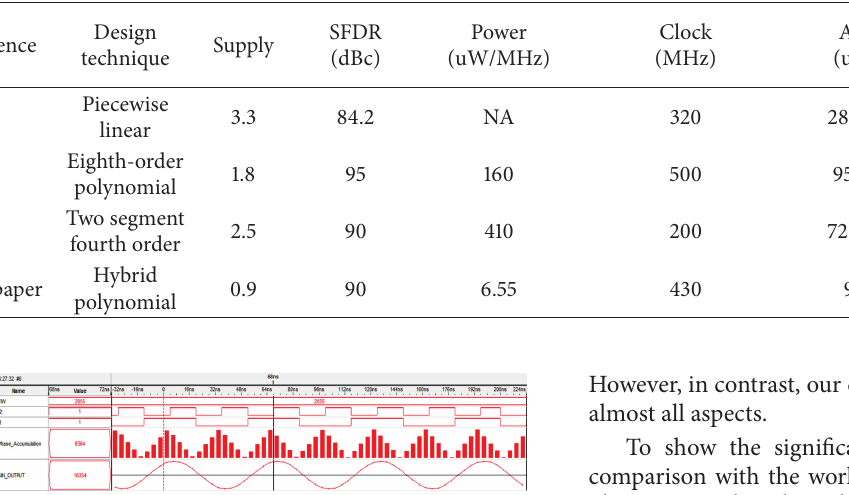
Figure 16: Design and debugging flowchart for FPGA-based DDFS implementation. Table 5: Performance Comparisons with published work.